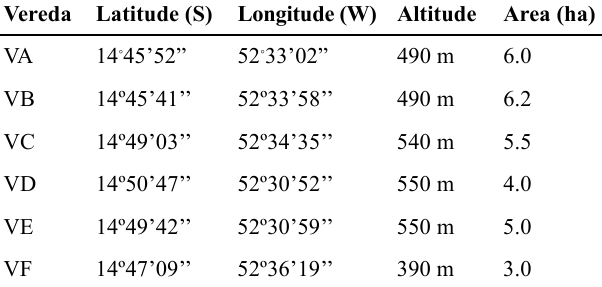
Table 1. Veredas and code: VA = Botina stream, VD and VE = Chupador stream, VC = Areal stream, VF = Coronel Vanique stream, and VB = Queixada stream. Geographic coordinates, altitude, and area of the Veredas surveyed in eastern Mato Grosso,